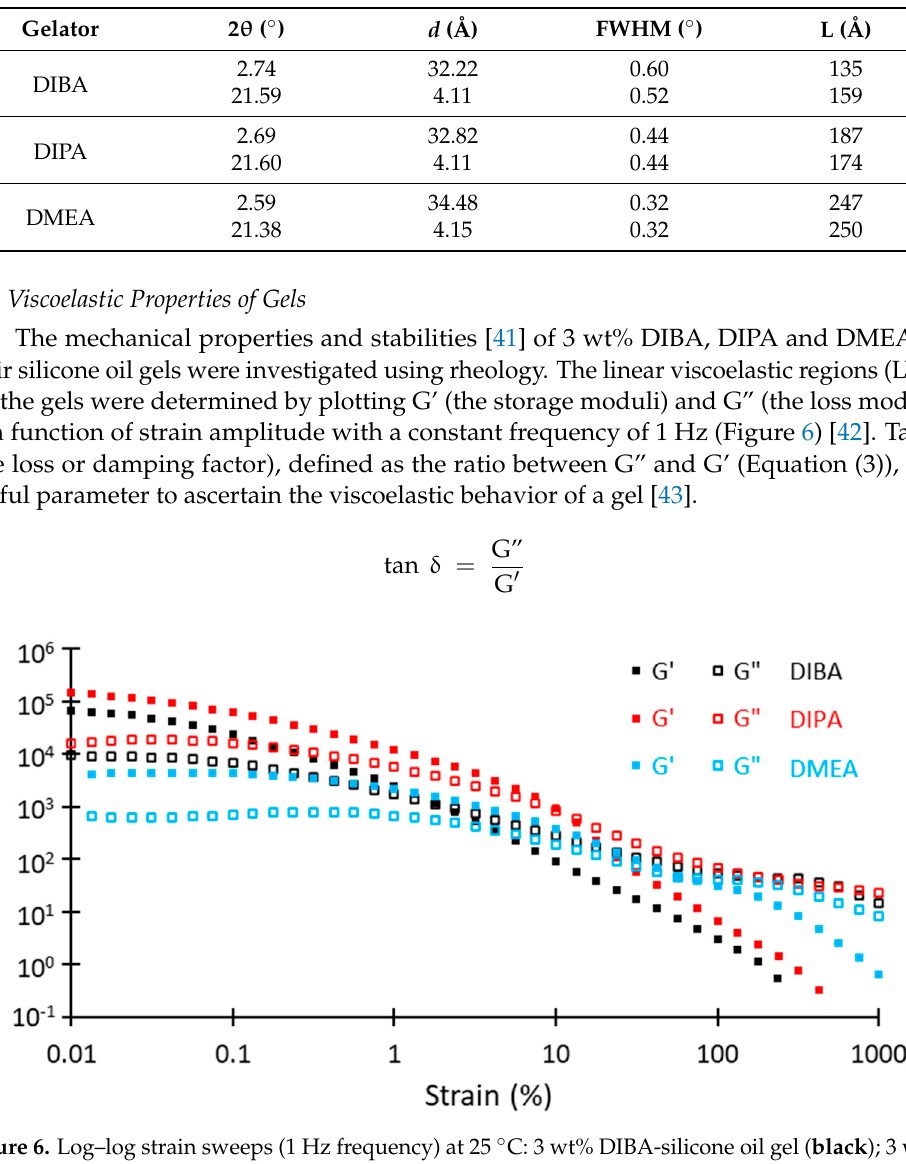
Table 5. Bragg diffraction angles (2 θ ), interplanar spacings ( d ), line widths at half the maximum intensities (FWHM) and calculated mean sizes of the ordered (crystalline) domains (L) for gels with 7 wt% gelator in silicone oil. The L values were calculated using the strongest intensity peaks, at θ ~2° and ~21°.